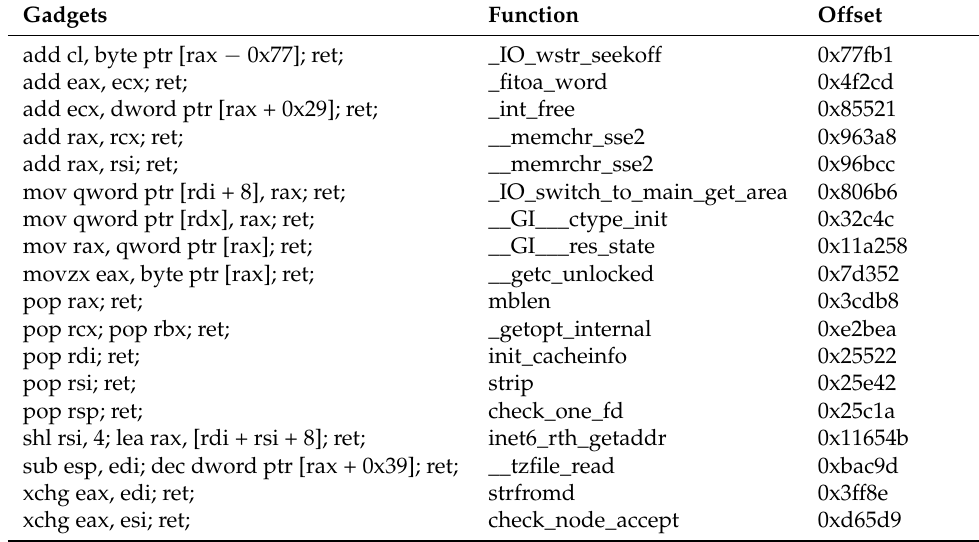
Table 2. Gadget list used in Graphene-SGX.